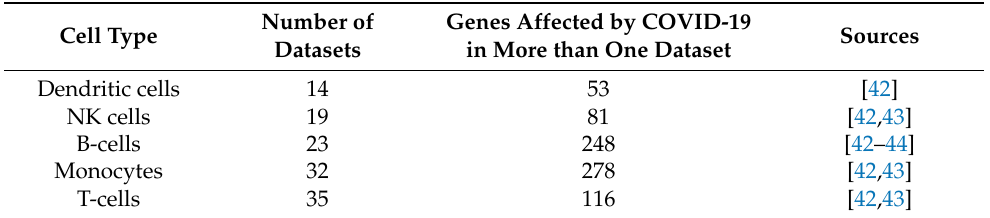
Table 4. Total number of COVID-19 data sets for each cell type extracted from Coronascape and used in this study. Each dataset corresponds to one